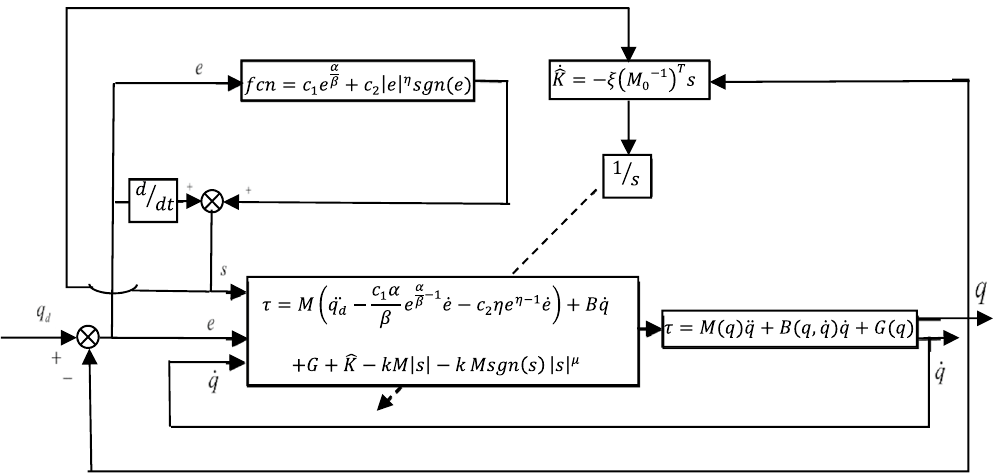
Figure 1. Schematic of the proposed